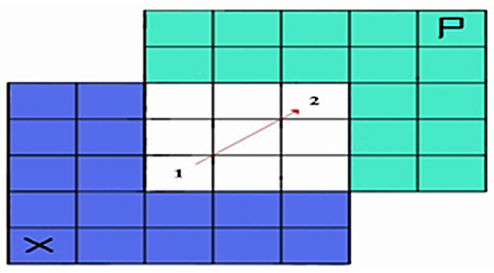
Figure 19. The DRP mechanism.